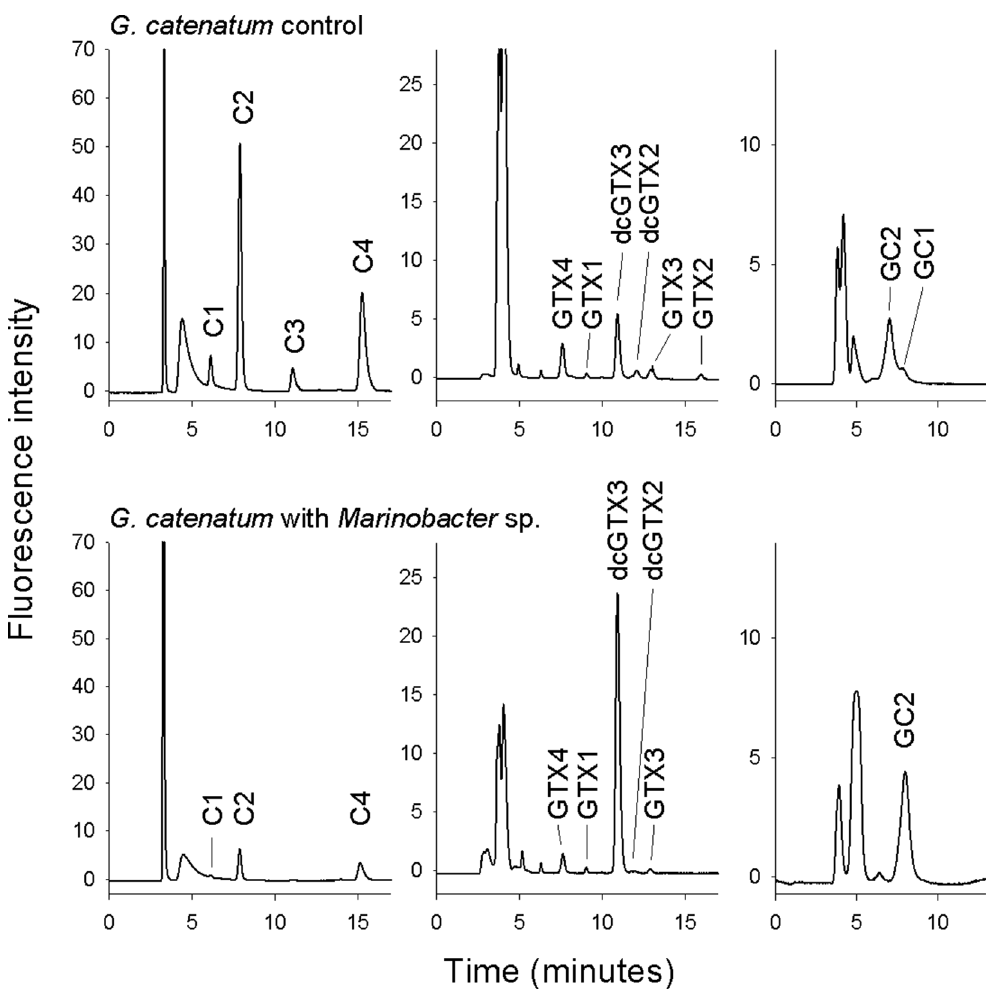
Figure 5. HPLC chromatogram comparison. Comparison of (a) Gymnodinium catenatum positive control (DE06 x LV01 cross with natural bacterial assemblage) and (b) with the addition of Marinobacter sp. DG879 (Gc/Mar).